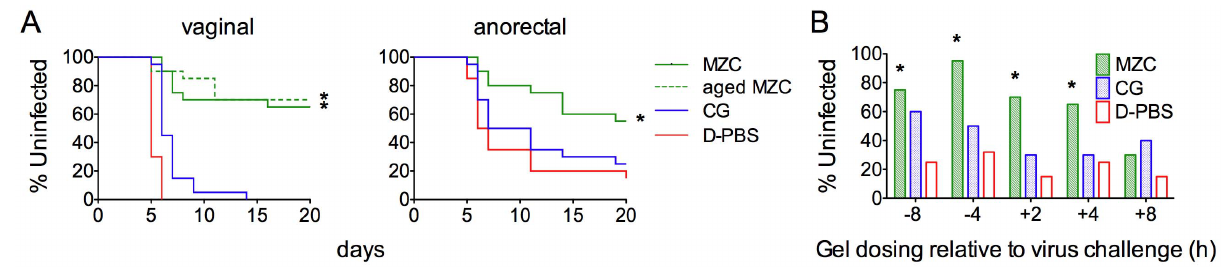
Figure 5. MZC protects mice against vaginal and anorectal HSV-2 infection. A) Depo-treated (vaginal) or untreated (anorectal) Balb/C mice were challenged with 10 6 pfu HSV-2 10 min after applying the indicated formulations (n=20/formulation). The percentages of uninfected animals over time, based on symptoms, are shown for each treatment group (*P , 0.05 vs. D-PBS and CG, Fisher’s exact test). B) Depo-treated Balb/C mice were treated with 10 m l of the indicated formulations intravaginally at different time points before or after HSV-2 challenge with 5 6 10 3 pfu (n=20/ formulation). The percentages of uninfected animals are shown for each time of gel dosing relative to challenge (*P , 0.05 vs. D-PBS, Fisher’s exact test).